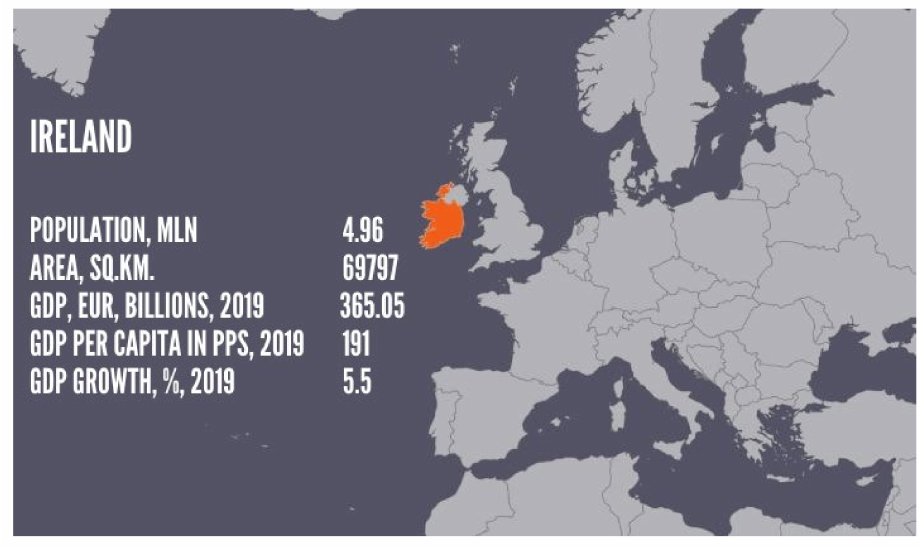
Figure 8. Stylized facts about Ireland (designed by the authors, based on [86,99,100]).